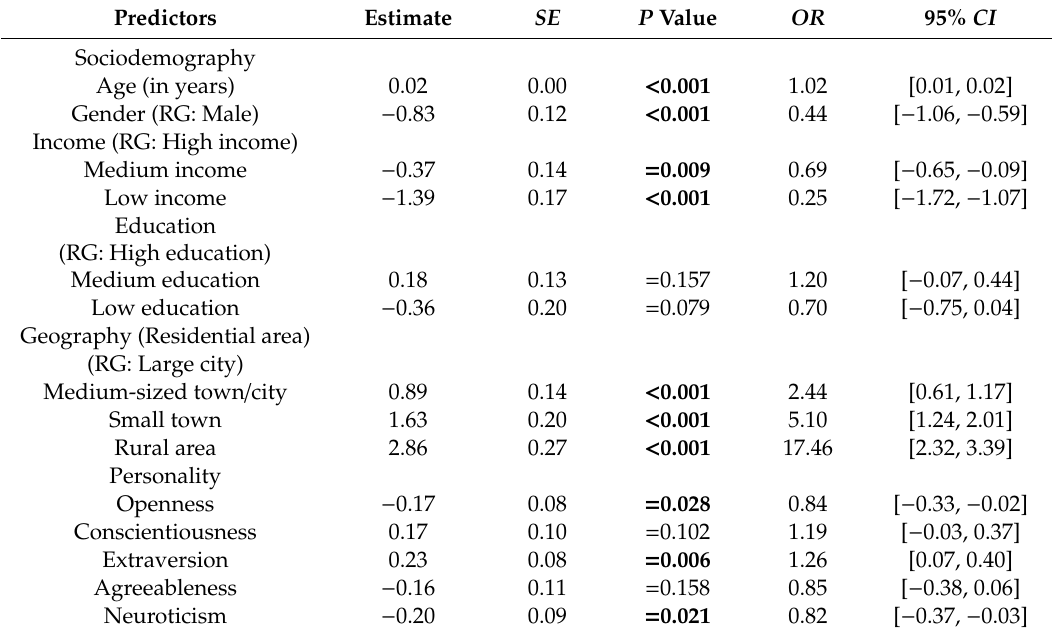
Table 1. Ordinal regression analysis to predict car